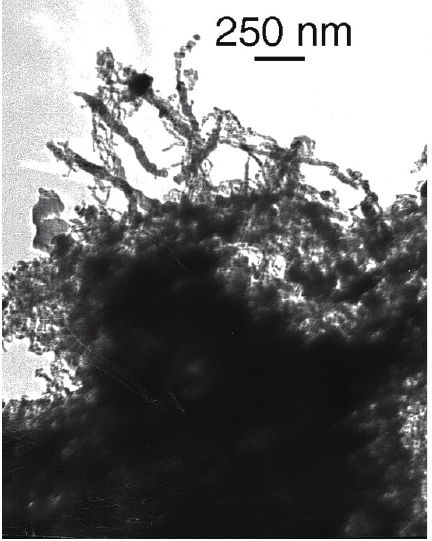
Figure 1: TEM image of carbon nanotube/metallic particles hybrids obtained on the pressed stainless steel pellets. Typical metallic particle agglomerations (black flakes) were observed for both Pt and Ag.